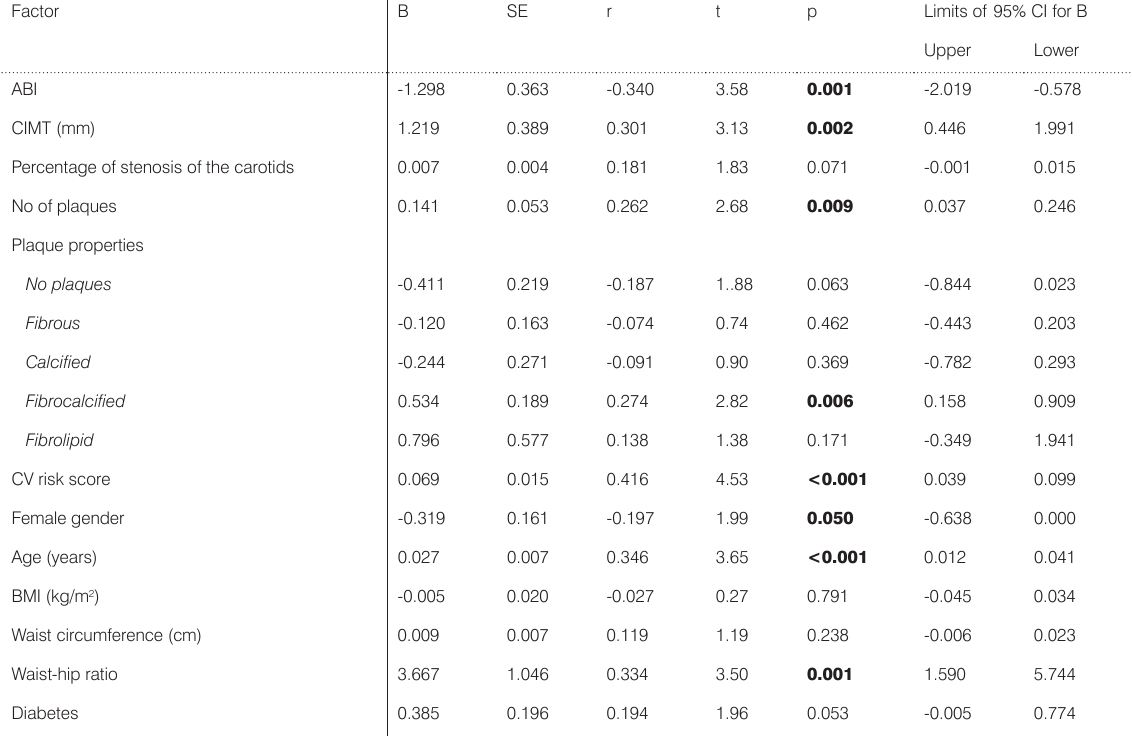
Table 2. Evaluation of the association of risk factors of interest with the number of afftected coronary blood vessels: univariate regression analysis Factor